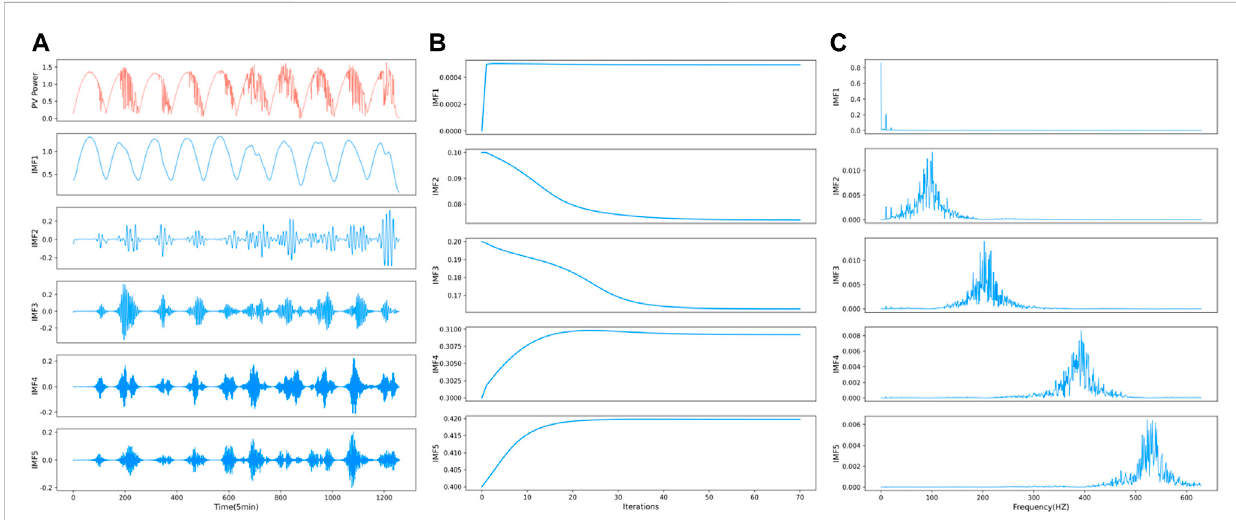
FIGURE 11 Decomposition results of ISSA-VMD: (A) shows each subsequence after decomposition, (B) represents center frequency of each subsequence, and (C) represents spectrum of each